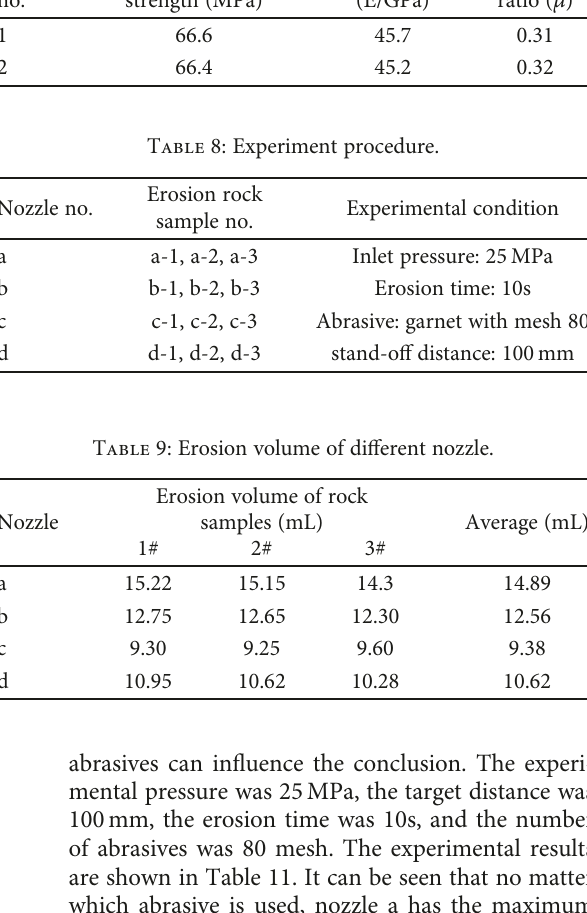
Table 7: Limestone mechanical properties. Sample